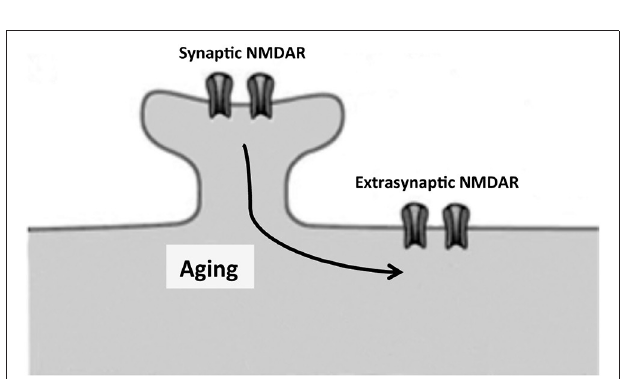
FIGURE 2 | Proposed movement, by lateral diffusion, of NMDA receptors from dendritic spines to extrasynaptic sites. Unbalance between synaptic and extrasynaptic NMDAR may contribute to cognitive decline in neuronal aging and neurodegenerative diseases as Alzheimer